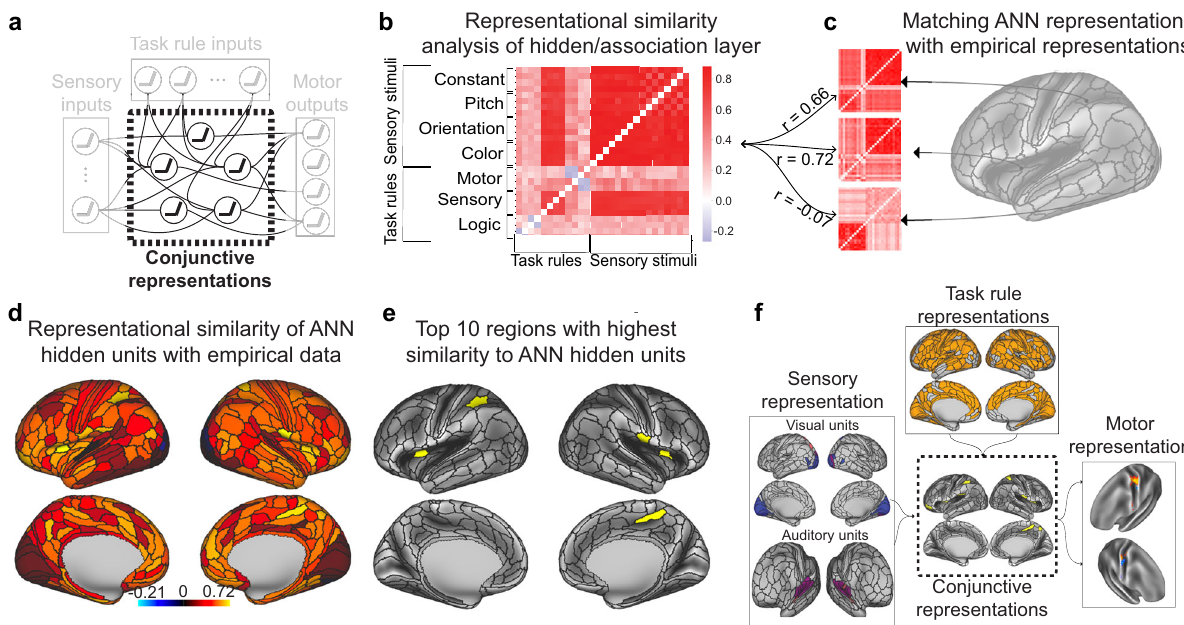
Fig. 5 Identifying conjunction hubs: brain areas (vertices) that contain task-relevant conjunctions of sensory stimulus and task rule activations. a The Guided Activation Theory states that there exist a speci fi c set of association (or hidden) areas that integrate sensory stimulus and task context activations to select appropriate motor response activations. In an ANN where task rules and sensory stimulus activations serve as inputs, the ANN ’ s hidden layers integrate rule and stimulus activations providing a computational framework that is analogous to the role suggested for association areas in the